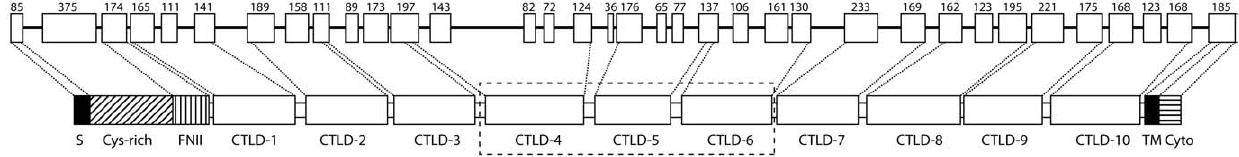
Figure 1. Structure of the chicken DEC205 gene. At the top, those parts of the 35 exons containing coding sequence are drawn to scale and labelled with their lengths in nucleotide residues. Introns are not to scale although their lengths relative to each other are approximately as drawn. The protein domain structure is shown below using shaded rectangles drawn to scale, with annotations: S, signal sequence; FNII, fibronectin type II; CTLD, C-type lectin like domain; TM, transmembrane region; Cyto, cytoplasmic region. Dotted lines connect the ends of domains to the encoding positions in exons. The dashed box indicates the three domains which were used to make the recombinant fusion protein used to raise monoclonal